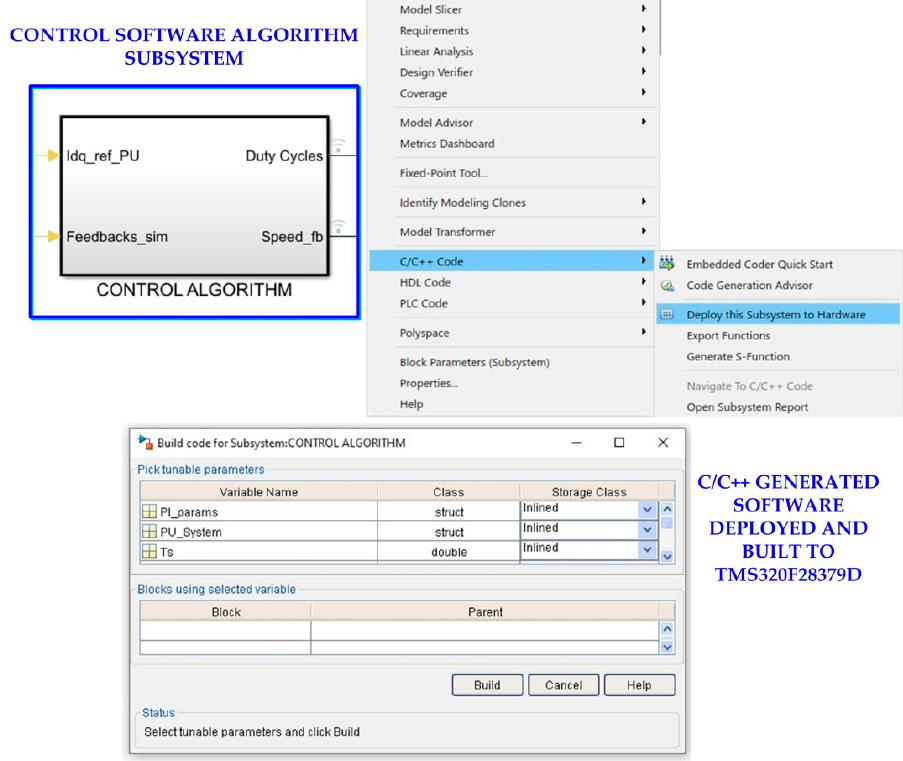
Figure 25. Hardware implementation settings for the PIL stage of the PMSM control system.